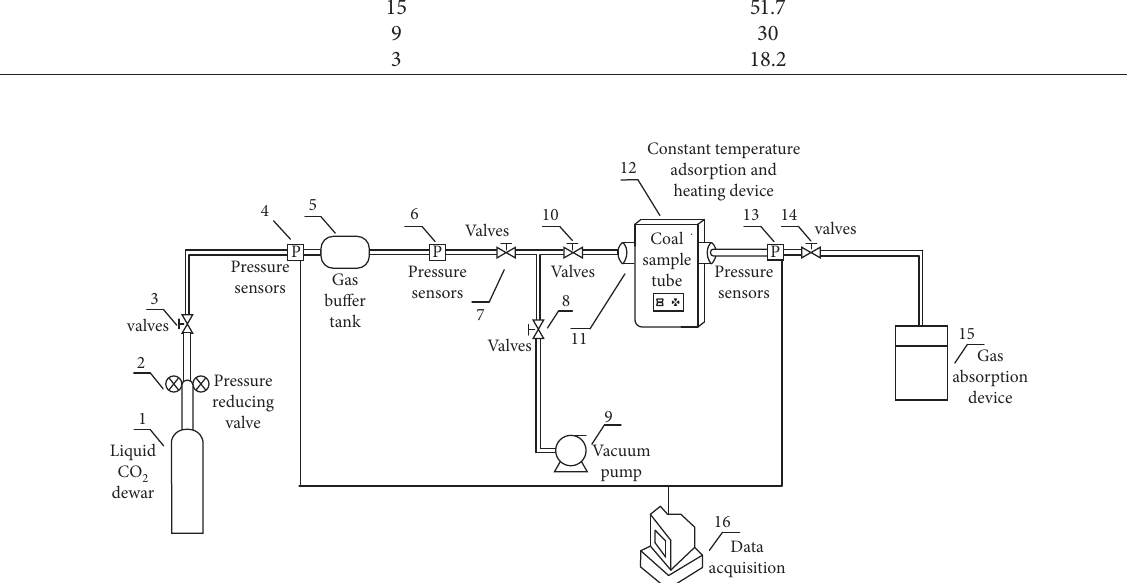
Table 1: Atmosphere composition for tests on the influence of CO Experiment